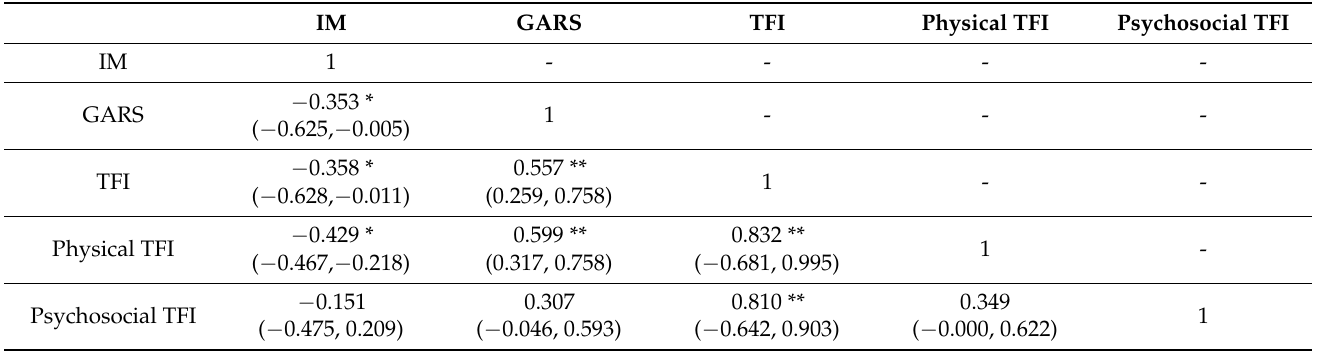
Table 3. Correlation matrix (95%